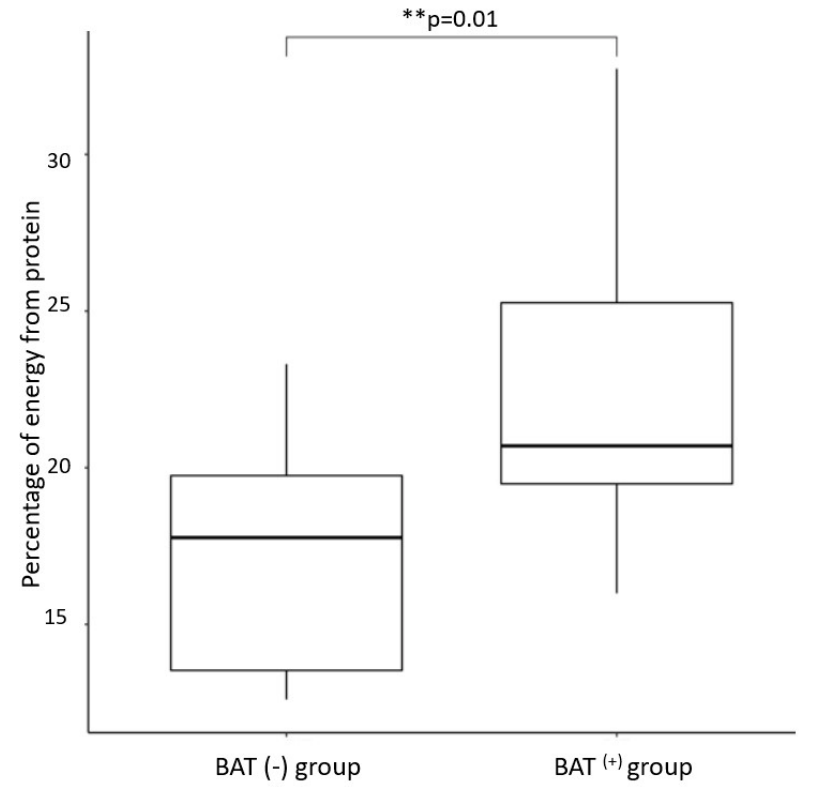
Figure 2. Percentage of daily energy intake from protein in subjects depending on BAT status ** p = 0.01.